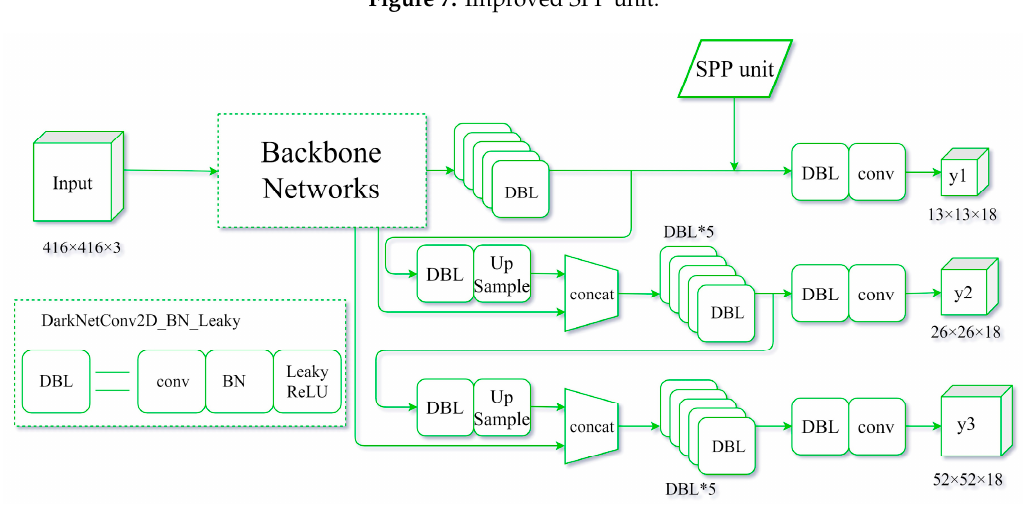
Figure 8. Structure of the SPP-YOLOv3 model.